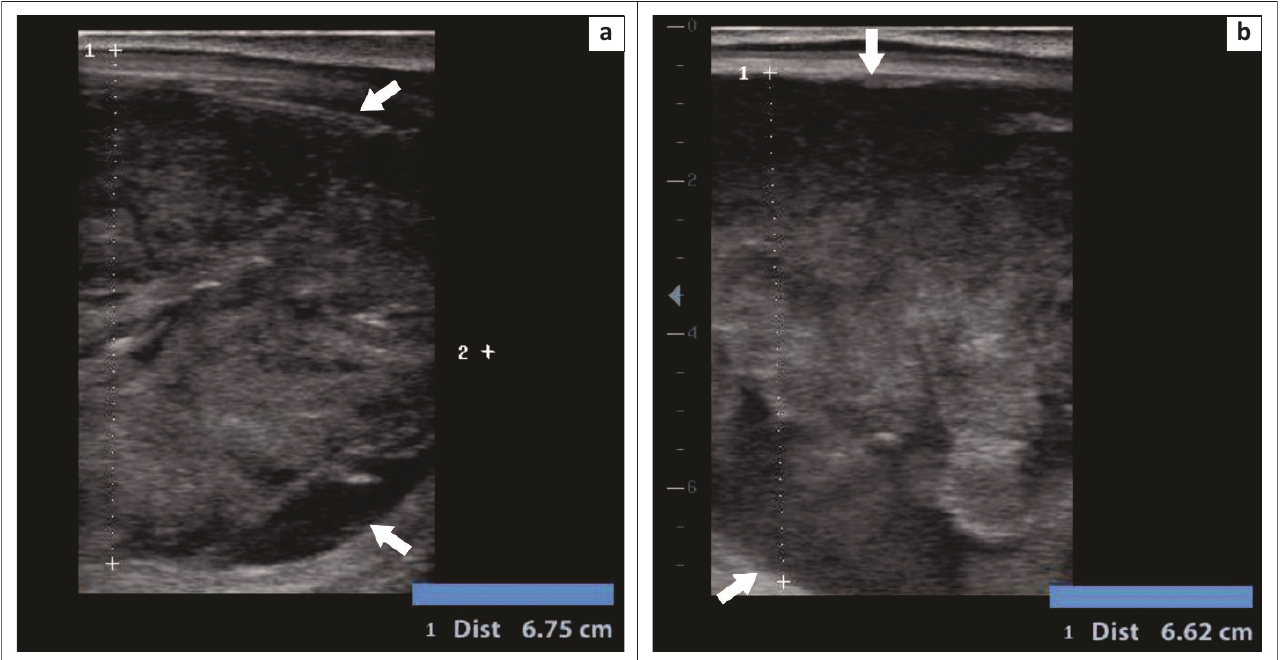
FIGURE 2: Ultrasound images of a structure ventral to the anus, later identified as a distended vesicular gland (a and b).